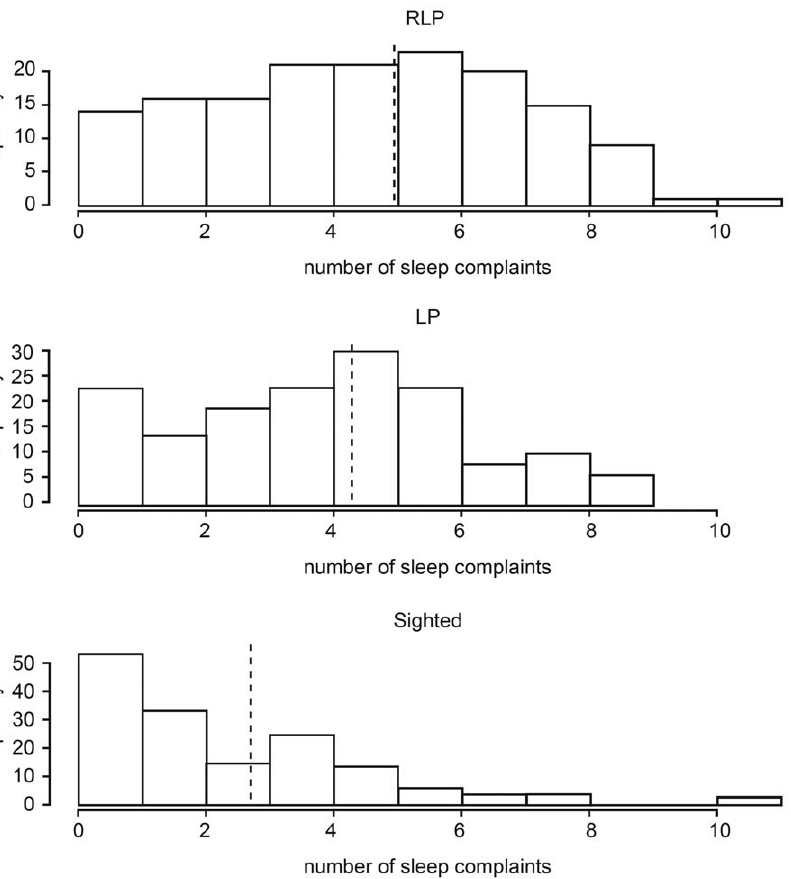
Figure 2. Distribution and frequencies of self-reported sleep complaints across the three subject groups. RLP – reduced light perception, LP – light perception in both eyes, FS – fully sighted. In each case, the mean number of sleep complaints is indicated by a vertical dashed line.